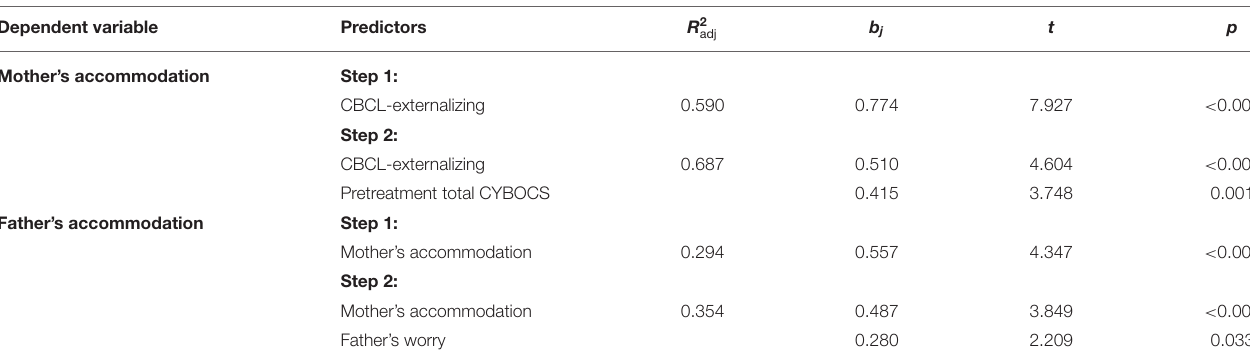
TABLE 3 | Hierarchical regression analysis for predictors of mother’s and father’s accommodation.